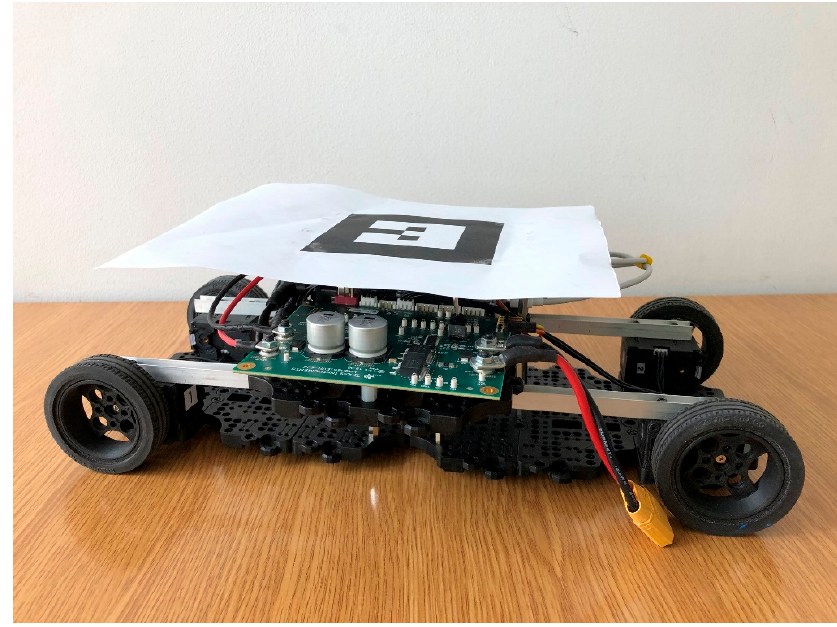
Figure 5. One of the skid-steer robot configurations.